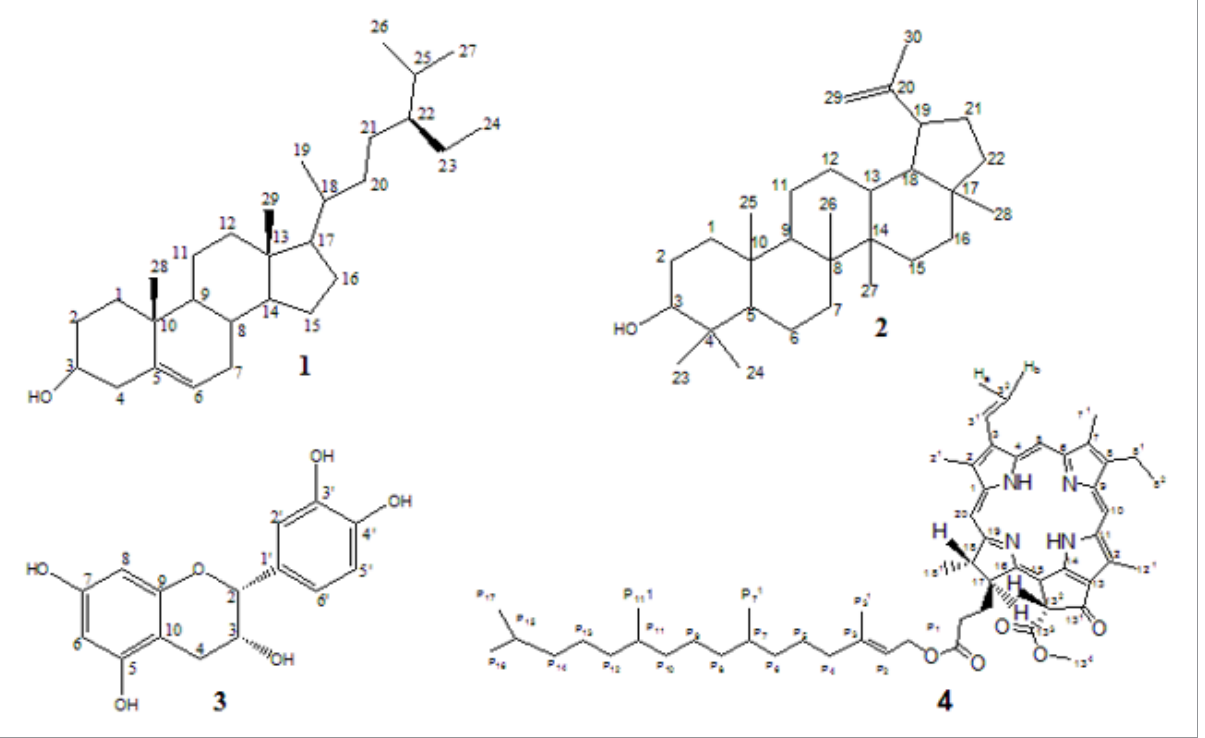
Figure 1: Chemical structures of compounds 1 ( β -sitosterol), 2 (lupeol), 3 (epicatechin) and 4 (phaeophytin a) isolated from Ficus sur.